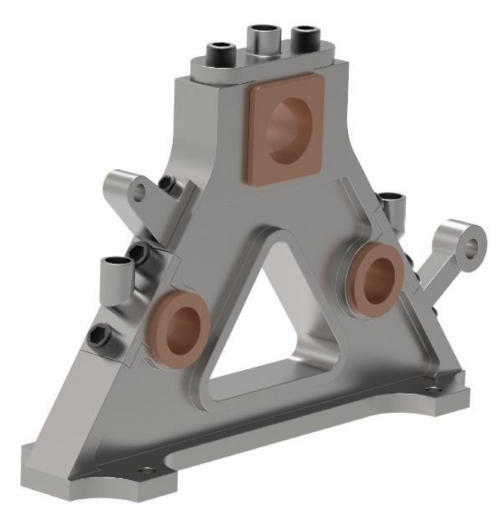
Figure 24. Bedplate.